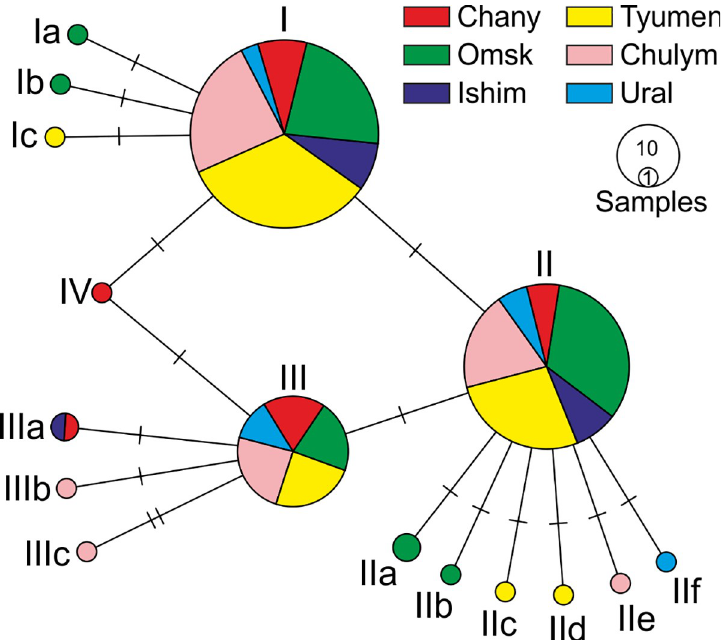
Fig 5. TSC network of mitochondrial haplotypes of West Siberia plain L . dispar populations. Romanian numbers mark the haplotypes numbers.